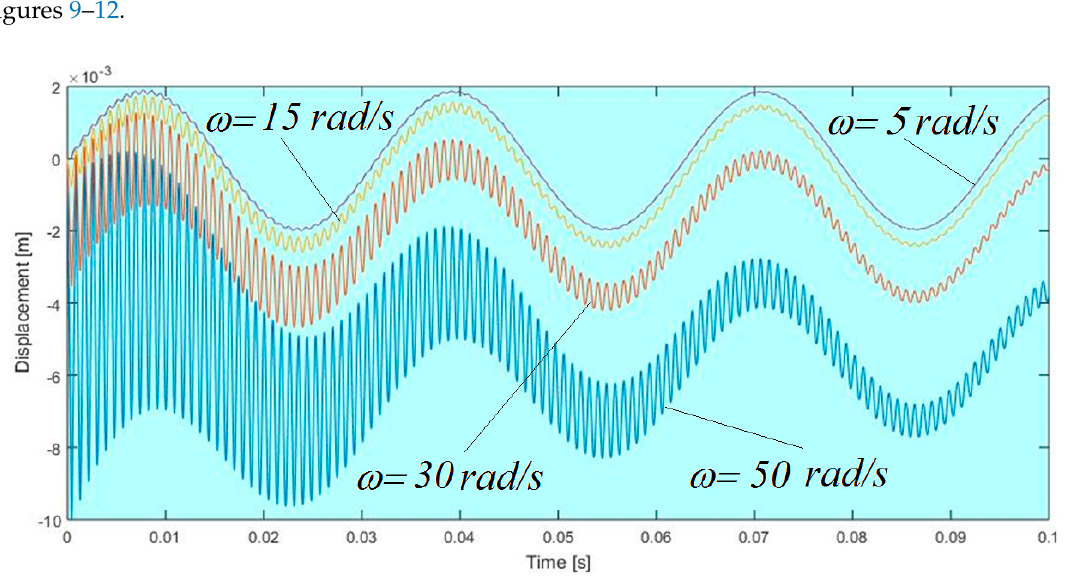
Figure 9. Cross-section area A = 0.00001 m 2 .